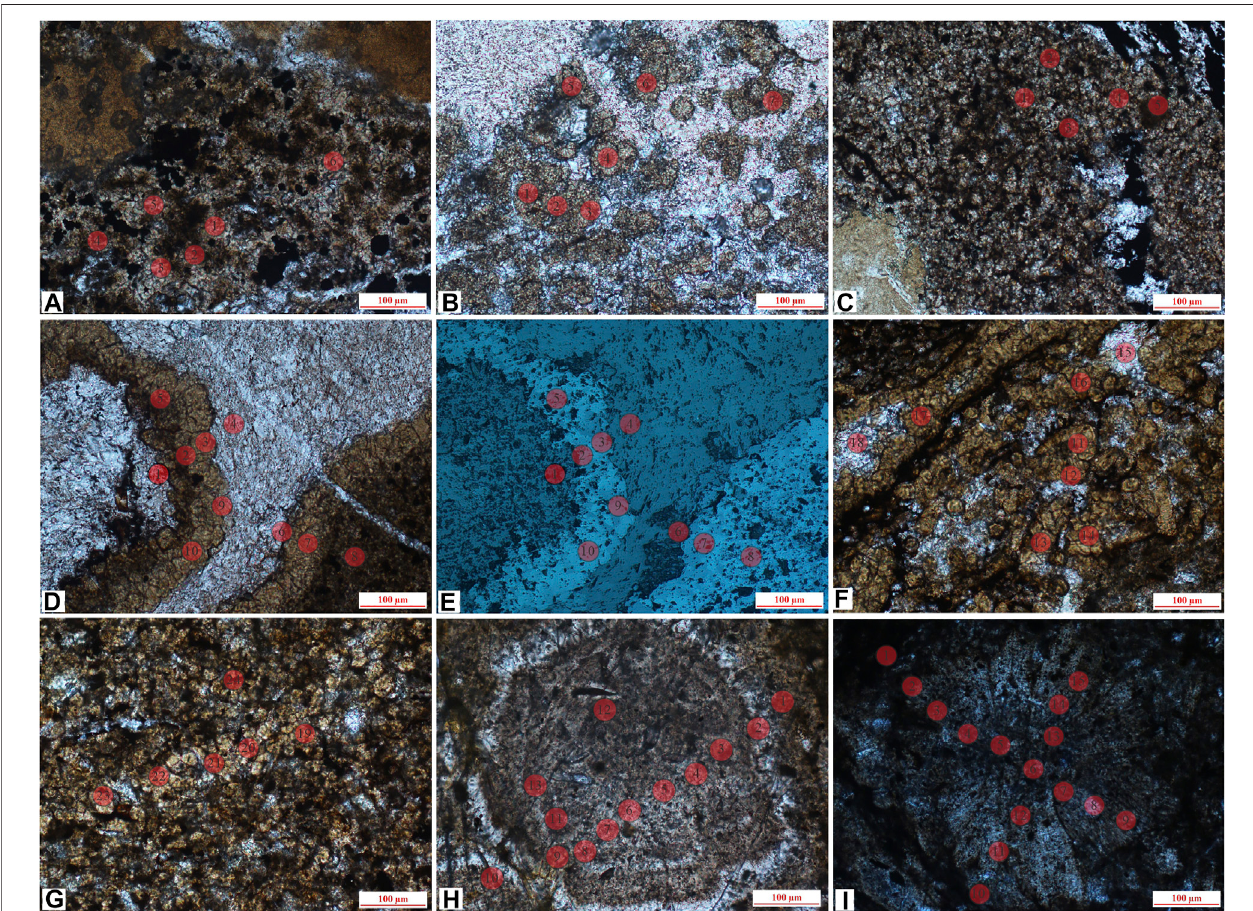
FIGURE 6 | In situ sites of microlite siderite, powder crystal siderite and sphaerosiderite, (A) J-13, microlite siderite, surrounded by clay minerals (lane-polarized light); (B) J-10 (2), powder crystal siderite, partially developed to petal-like siderite (lane-polarized light); (C) J-14, the powder crystal siderite is evenly distributed (lane- polarized light); (D) J-17 (1), powder crystal siderite and calcite (lane-polarized light); (E) re fl ecting light of (D) ; (F) J-17 (2), powder crystal siderite, partially developed to petal-like siderite (lane-polarized light); (G) J-17 (3), powder crystal siderite (lane-polarized light); (H) J-4, concentric siderite (lane-polarized light); (I) . J-7, petal-like siderite (lane-polarized